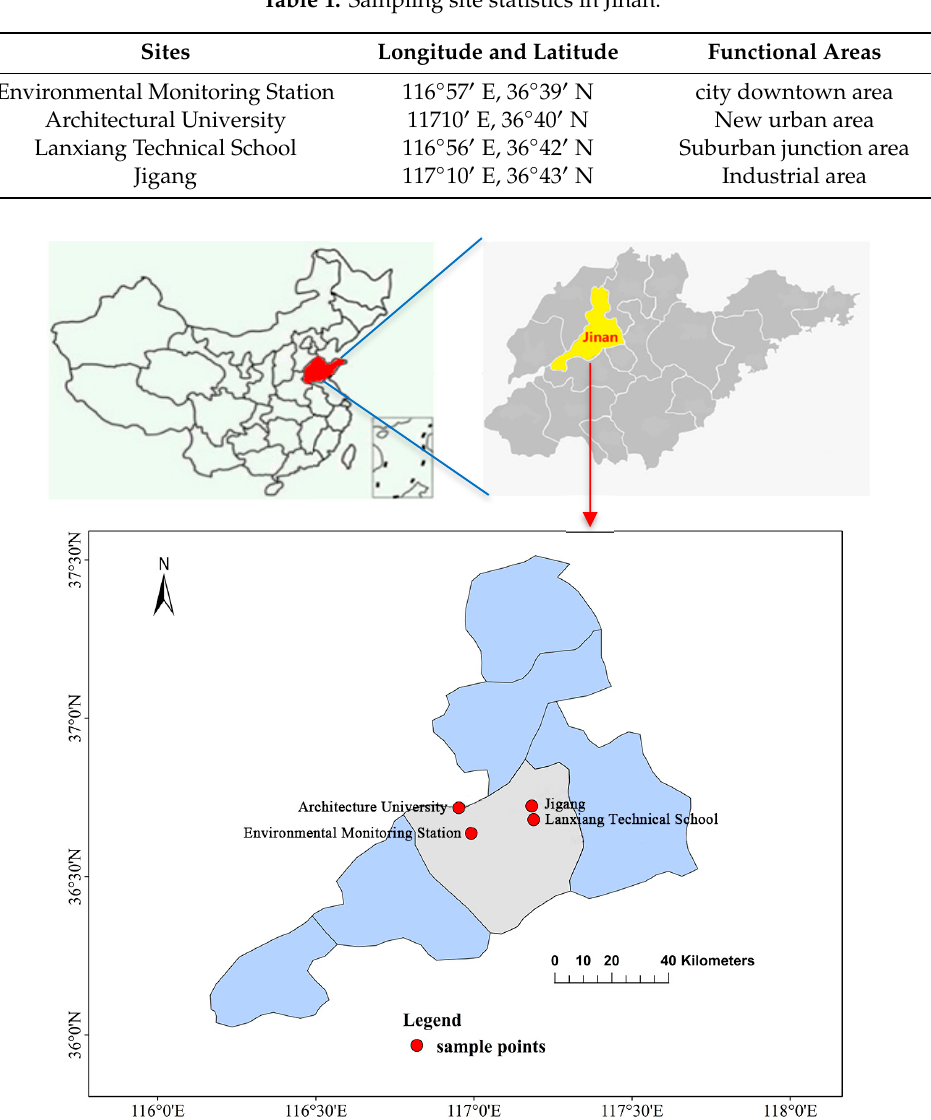
Figure 1. The four sampling sites in Jinan, China. Table 1. Sampling site statistics in Jinan.